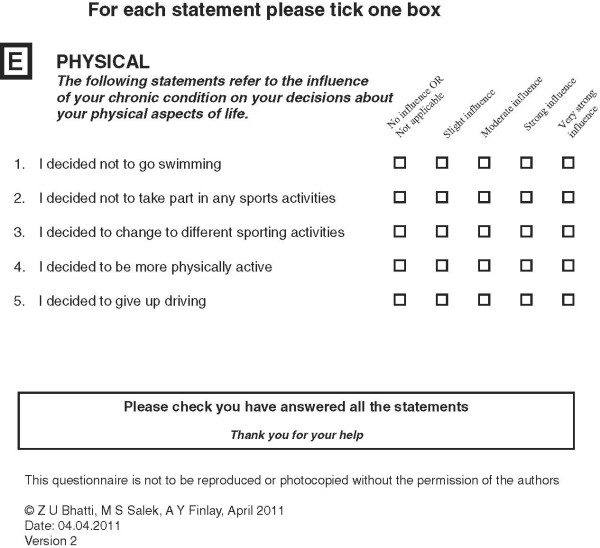
The 32-items MLCDP Part 3.